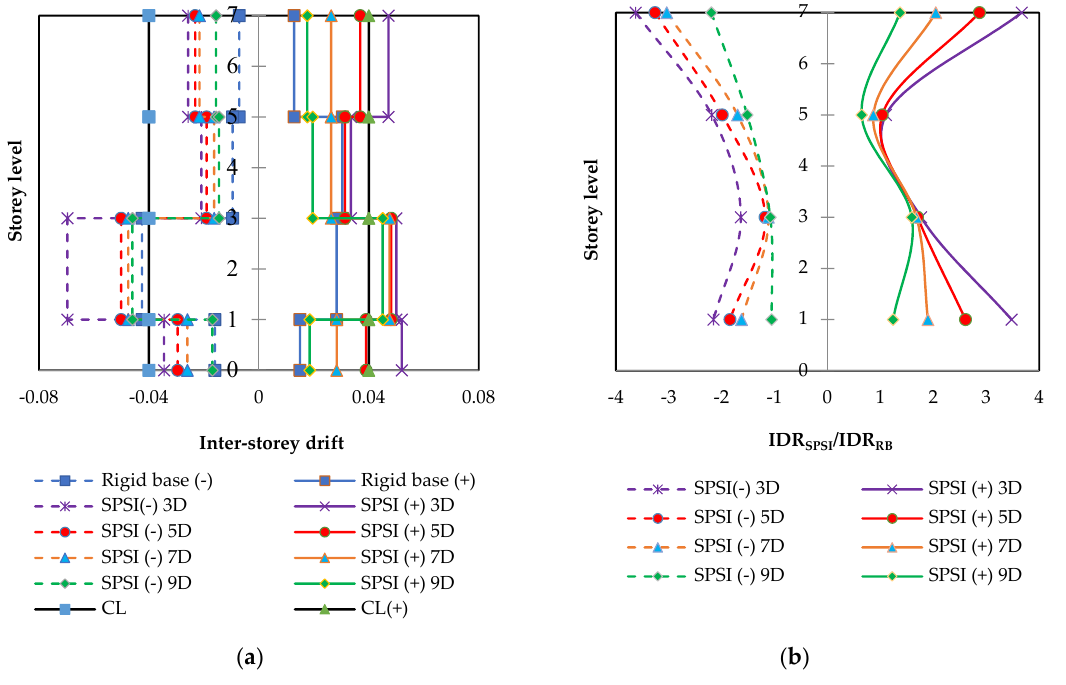
Figure 16. Effect of S/D ratio on ( a ) inter-story drift ratio and ( b ) IDR SPSI /IDR RB of soil-pile-supported structural models compared to a rigid-base structural model.